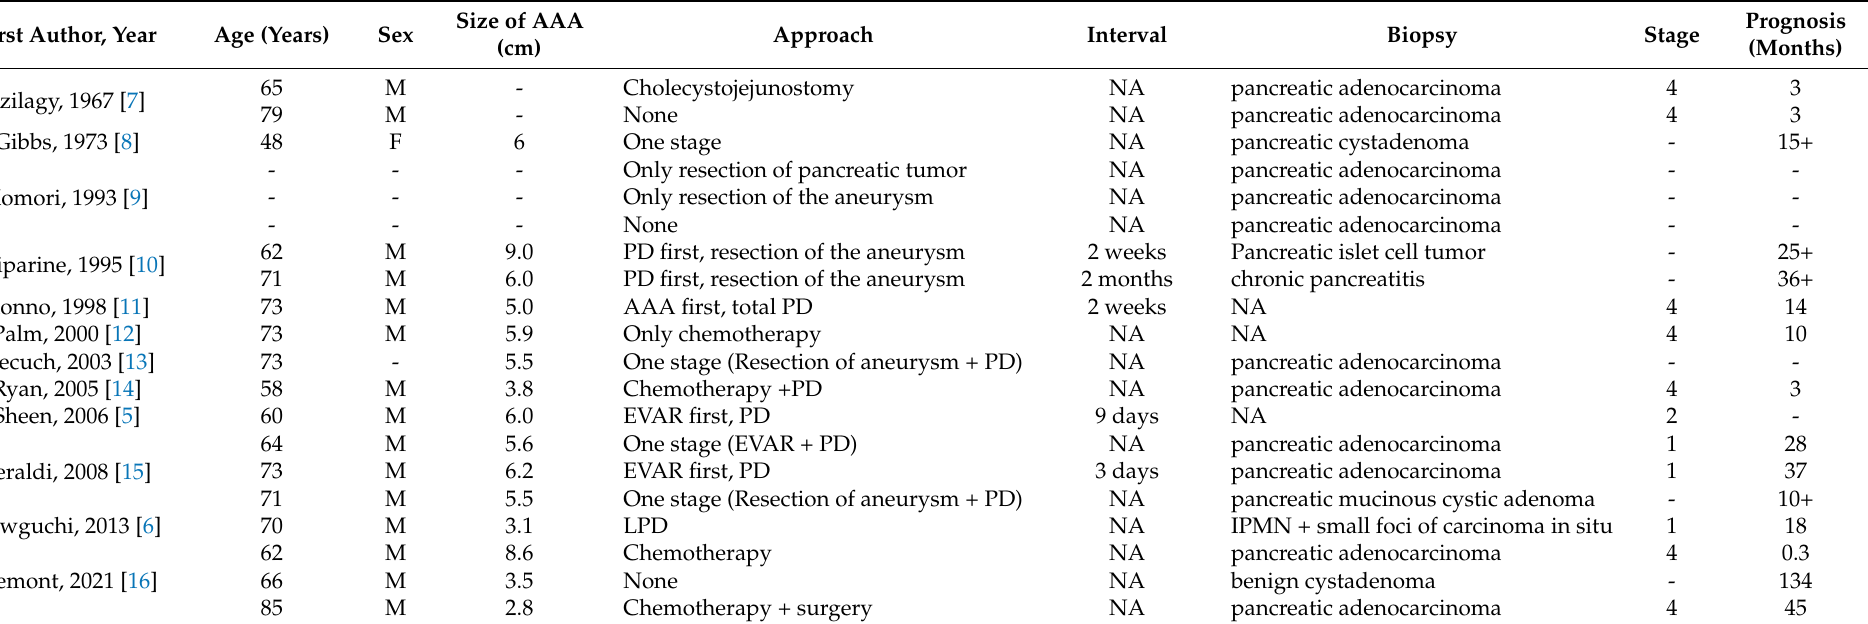
Table 1. Summary of AAA with pancreatic diseases in the